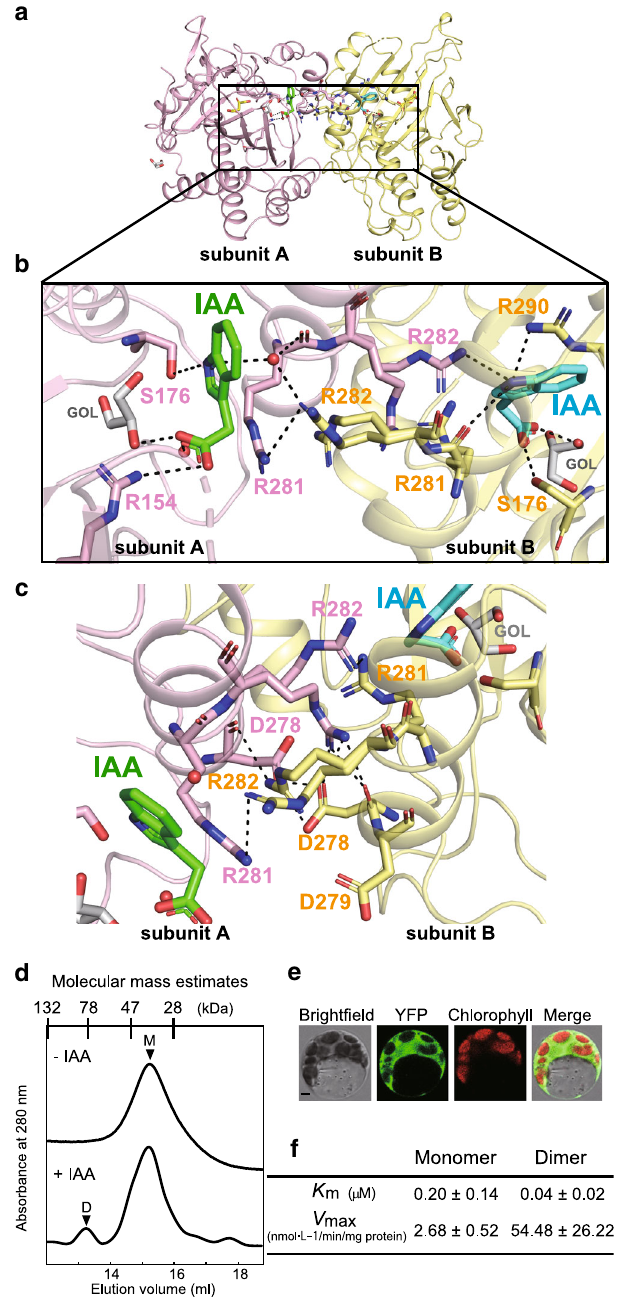
Fig. 4 OsDAO forms an IAA-mediated dimer structure to trigger its enzyme activity. a Overall structure of the dimer form of OsDAO. b , c Detailed interactions at the dimer – dimer interface of the OsDAO bound to IAA (green and cyan stick forms), the residues surrounding the interface are represented by a stick model, shown as pink and yellow sticks. The hydrogen bonds mediated by water molecule (red spheres) are also indicated by dashed lines. d A typical elution pro fi le of OsDAO sample under the presence of IAA condition in gel fi ltration. The proposed conformation of each eluted peak is indicated by M (monomer) and D (dimer). e BiFC analysis of dimeric interaction of DAO. Scale bar = 5 μ m. f Kinetic analysis of monomer and dimer of OsDAO. Comparison of K m and V max calculated by the corresponding Lineweaver – Burk plots ( n = 3 biologically independent